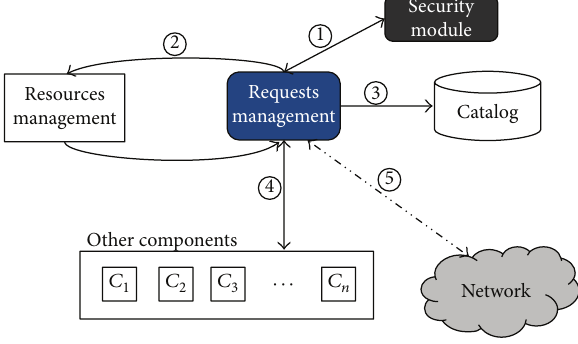
Figure 6: Services